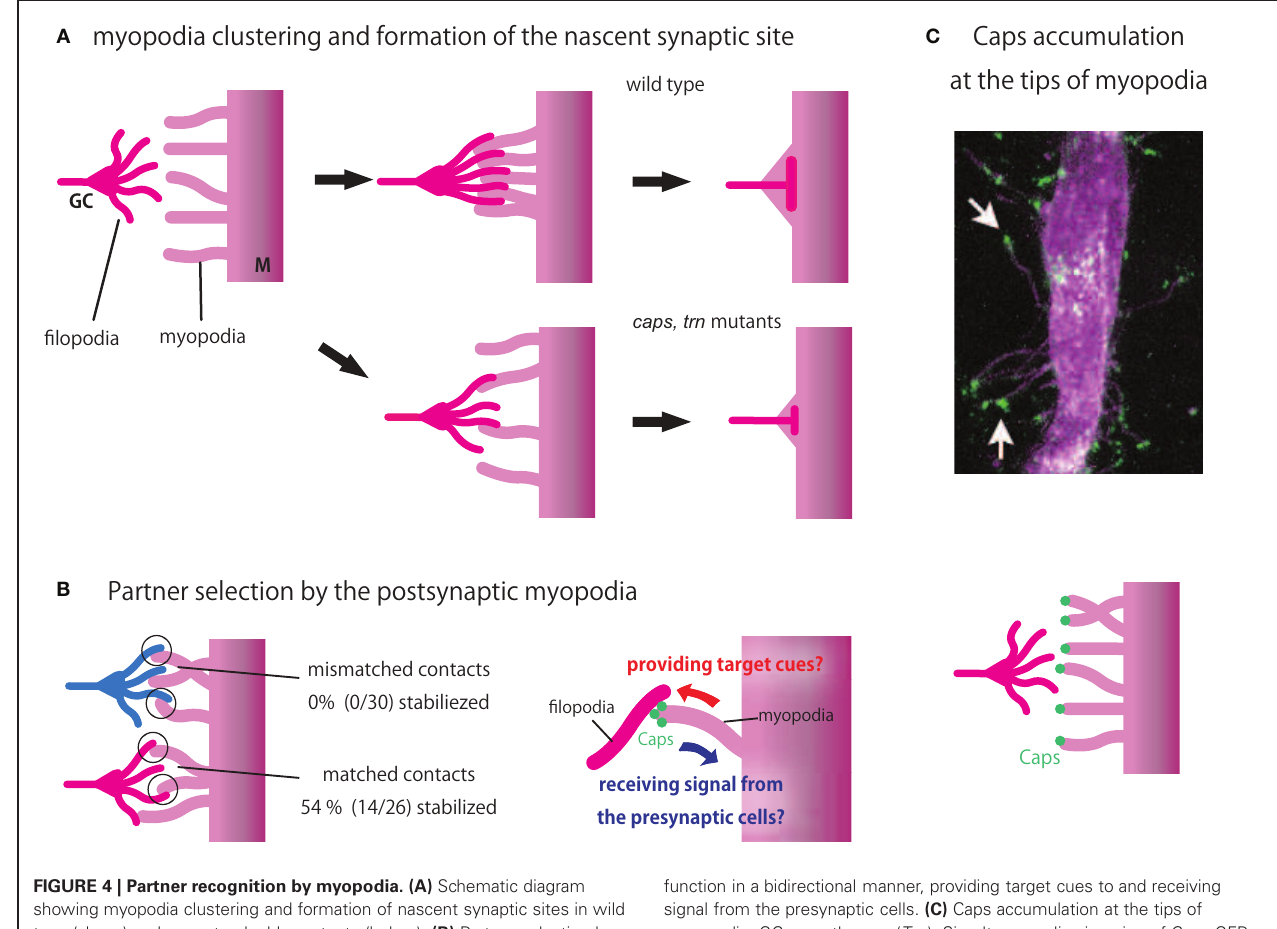
FIGURE 4 | Partner recognition by myopodia. (A) Schematic diagram showing myopodia clustering and formation of nascent synaptic sites in wild type (above) and caps, trn double mutants (below). (B) Partner selection by myopodia ( Left ). While 54% of myopodial contacts with a partner motor neuron (magenta) are stabilized, none of the contacts with the non-partner motor neuron ( blue ) are stabilized ( Right ). Caps at the tip of myopodia may